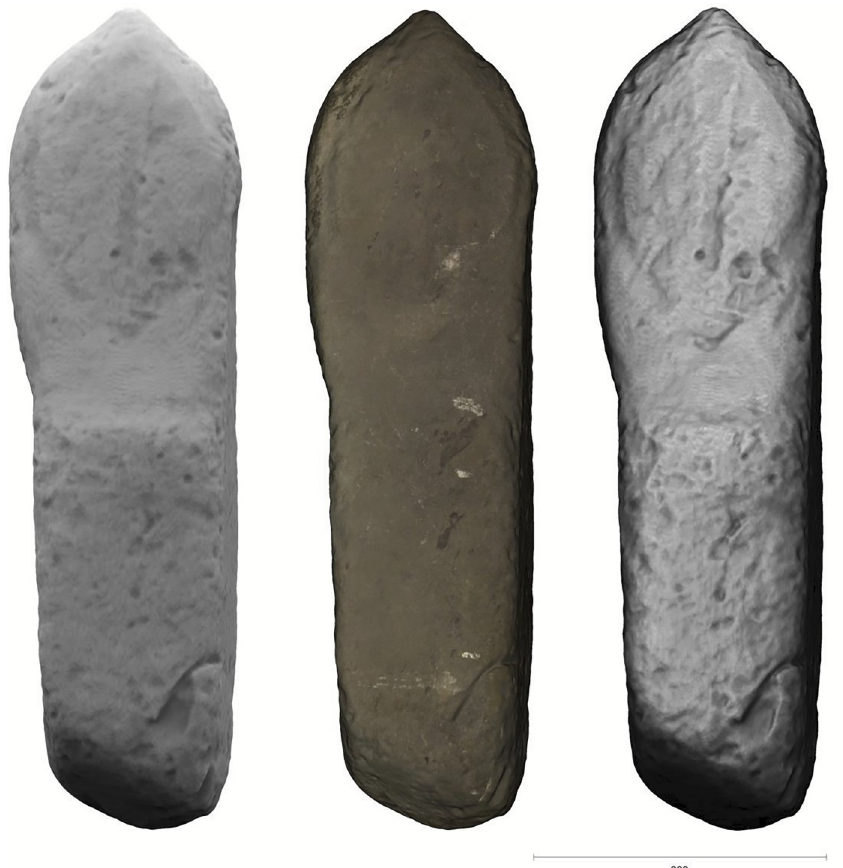
Fig 14. Tunnug 1. Turkic stela found at the edge of structure 29: standard model (left), textured (middle), contrast enhanced (right).